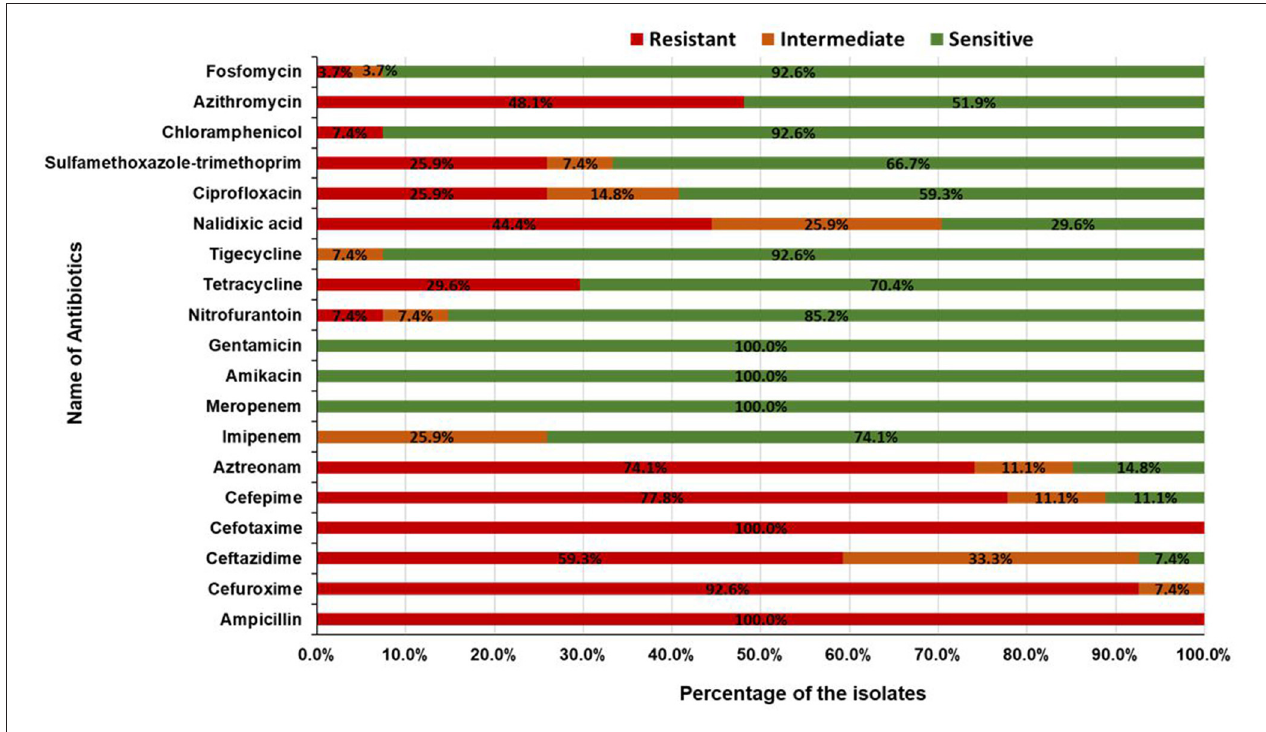
FIGURE 6 | Antibiotic resistance patterns of pathogenic ESBL producing E. coli isolates.